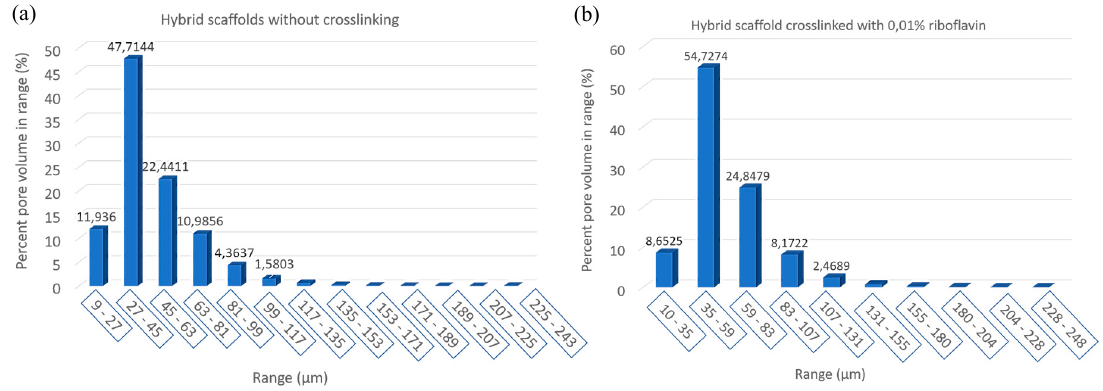
Table 2. Calculations of closed, open and total porosity generated by CTAn software. Scaffolds Without Crosslinking Scaffolds Crosslinked with 0.01% Riboflavin Figure 8. Block charts of pore size distribution in the produced sca ff olds: ( a ) Without crosslinking and Figure 8. Block charts of pore size distribution in the produced scaffolds: ( a ) Without crosslinking and ( b ) crosslinked with 0.01% ( b ) crosslinked with 0.01% riboflavin.